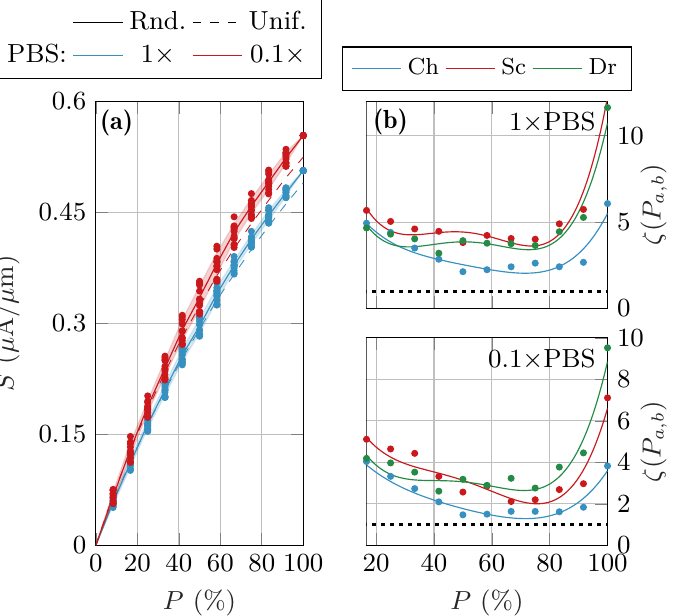
Figure 5. ( a ) Device sensitivity as a function of the activation percentage calculated for twelve ran- domized activated receptors configurations corresponding to the same channel-centered